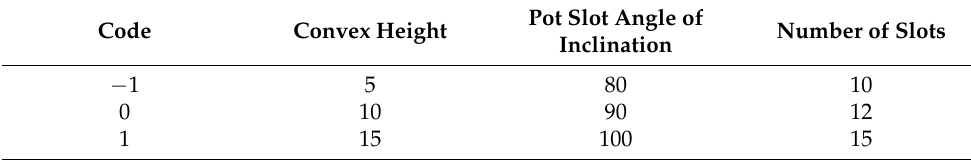
Table 3. Factors and levels of test.